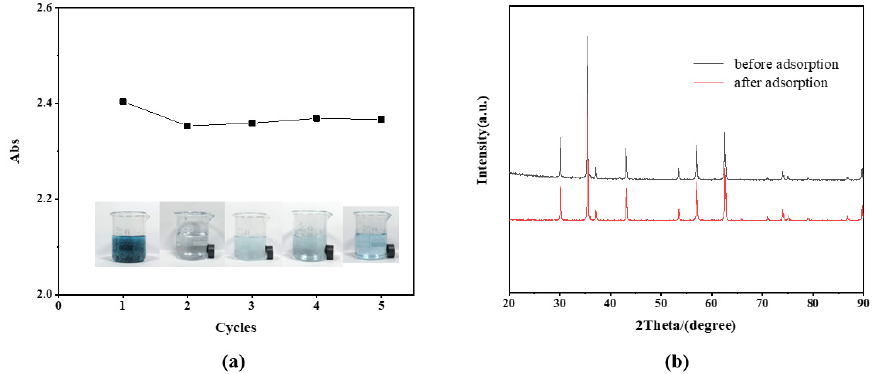
Figure 6. ( a ) Recyclability of Fe 3 O 4 after MB adsorption. (The illustrations from left to right are the initial methylene blue solution after adding the magnetic Fe 3 O 4 powder, and the water-dispersed magnetic powder which was attracted by the magnet after the first/second/third/fourth-cycle use and cleaning) ( b ) XRD of Fe 3 O 4 before and after the adsorption of MB.